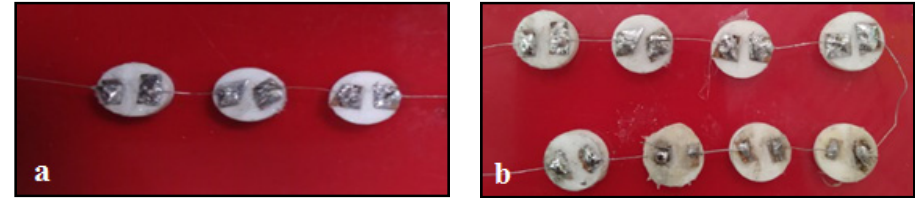
Figure 2. Contact pads fixed on alumina substrate with the coated sensing material connected by lead-coated copper wires in series of ( a ) three sensor array ( b ) eight sensor array.